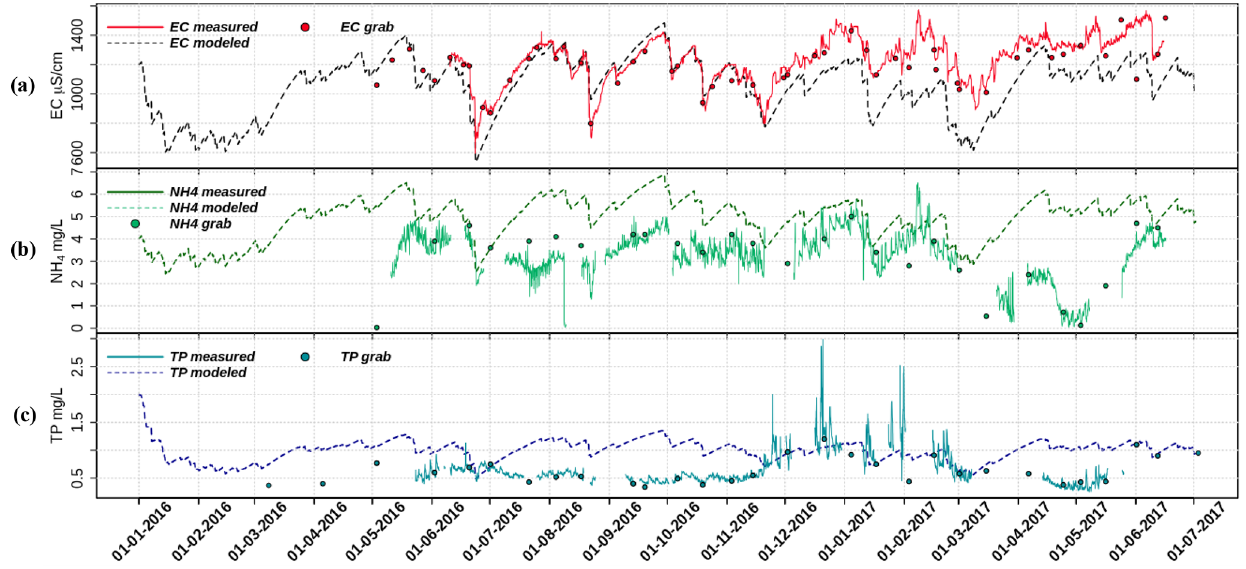
Figure 3. Plots of fixed-end-member mixing model predicted (a) EC, (b) NH 4 , and (c) TP with their measured time series data and the discrete sampling results. See Tables S4–S6 for the correlation tests performed on the